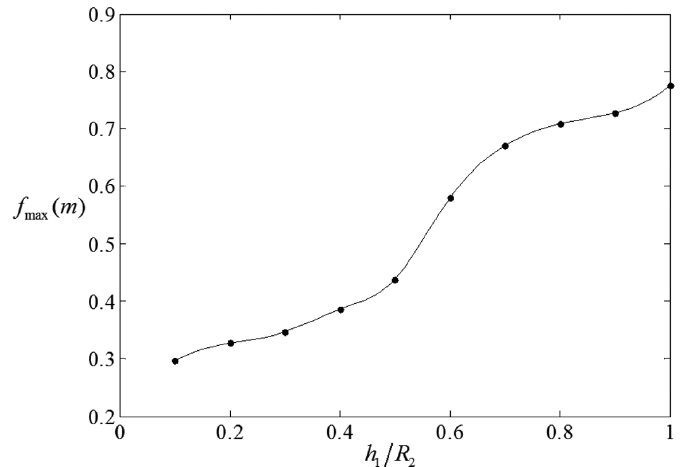
Fig. 13. Maximum amplitude in the time history of the sloshing displacement at the container wall under the Kobe seismic excitation versus h 1 / R 2 for R 1 / R 2 = 0.4.